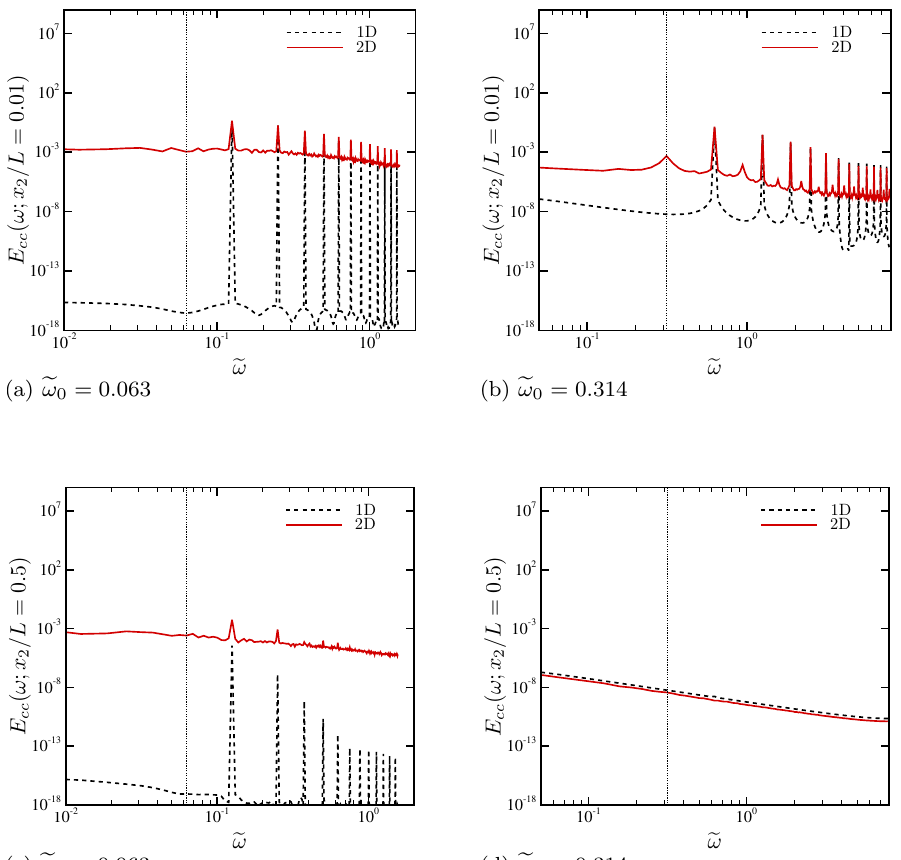
Figure 13. Comparison of temporal power spectral density of salt concentration at x 2 / L = 0.01